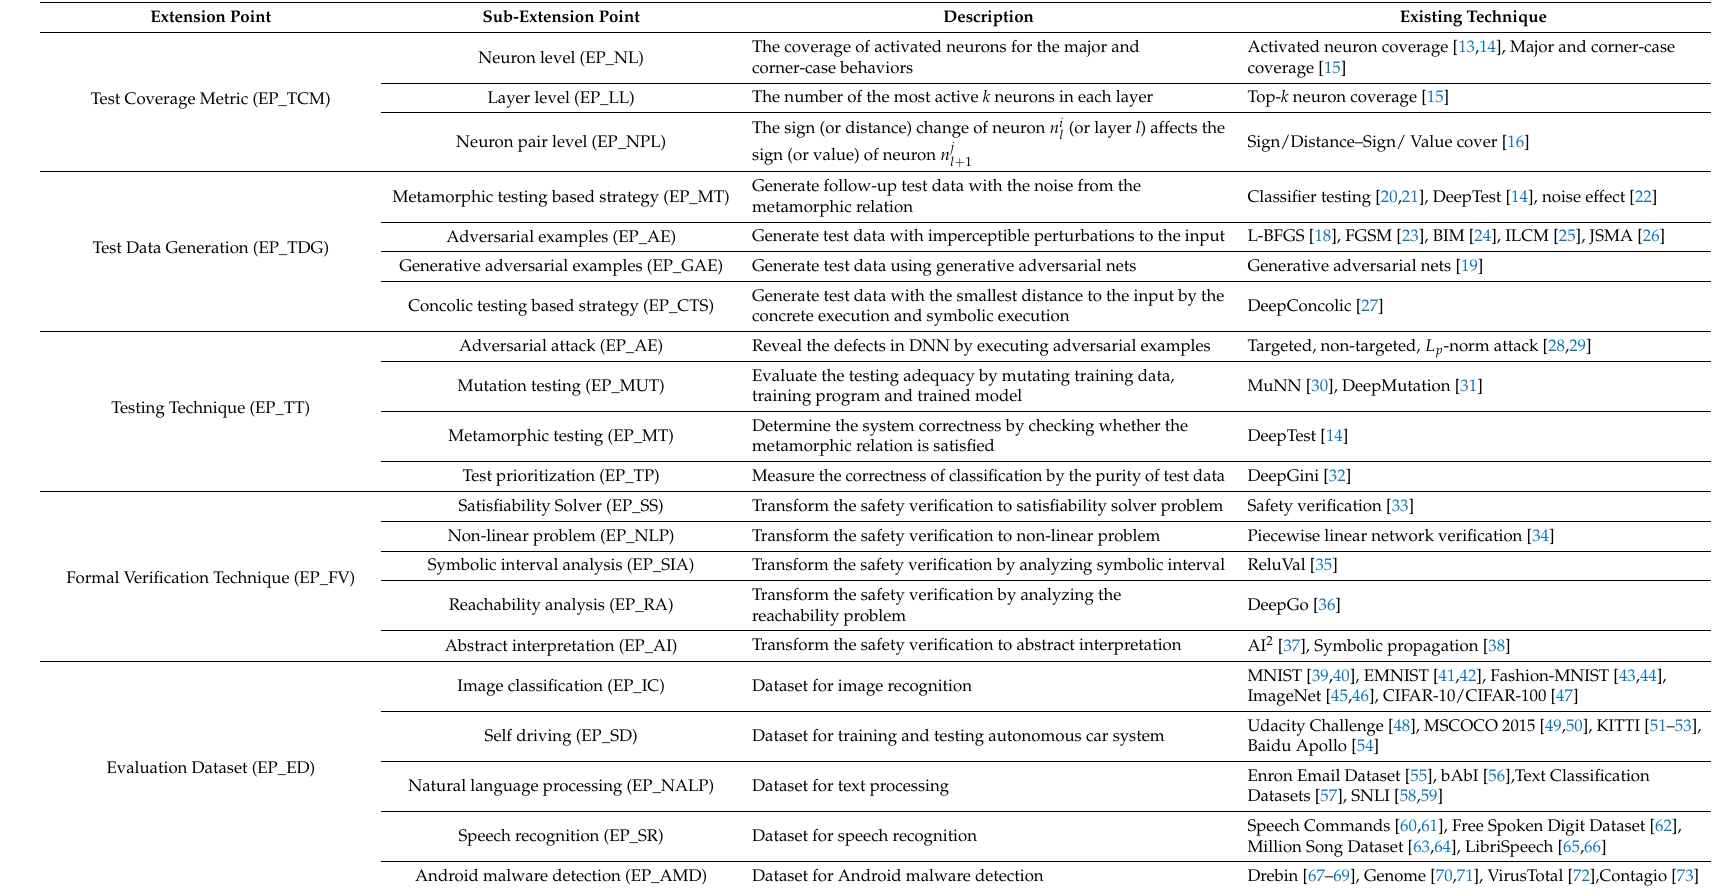
Table 1. Summary of extension points and existing techniques in